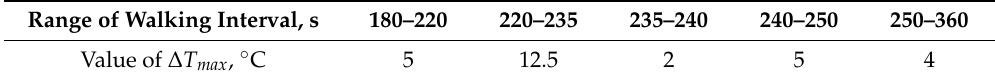
Table 5. Values of ∆ T max for walking interval between 180 and 360.